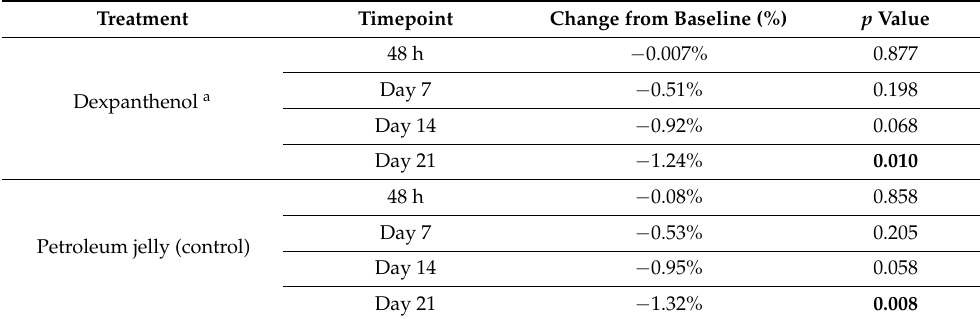
Table 3. Mean change of thermographic values versus baseline after non-ablative facial laser (Study 1).